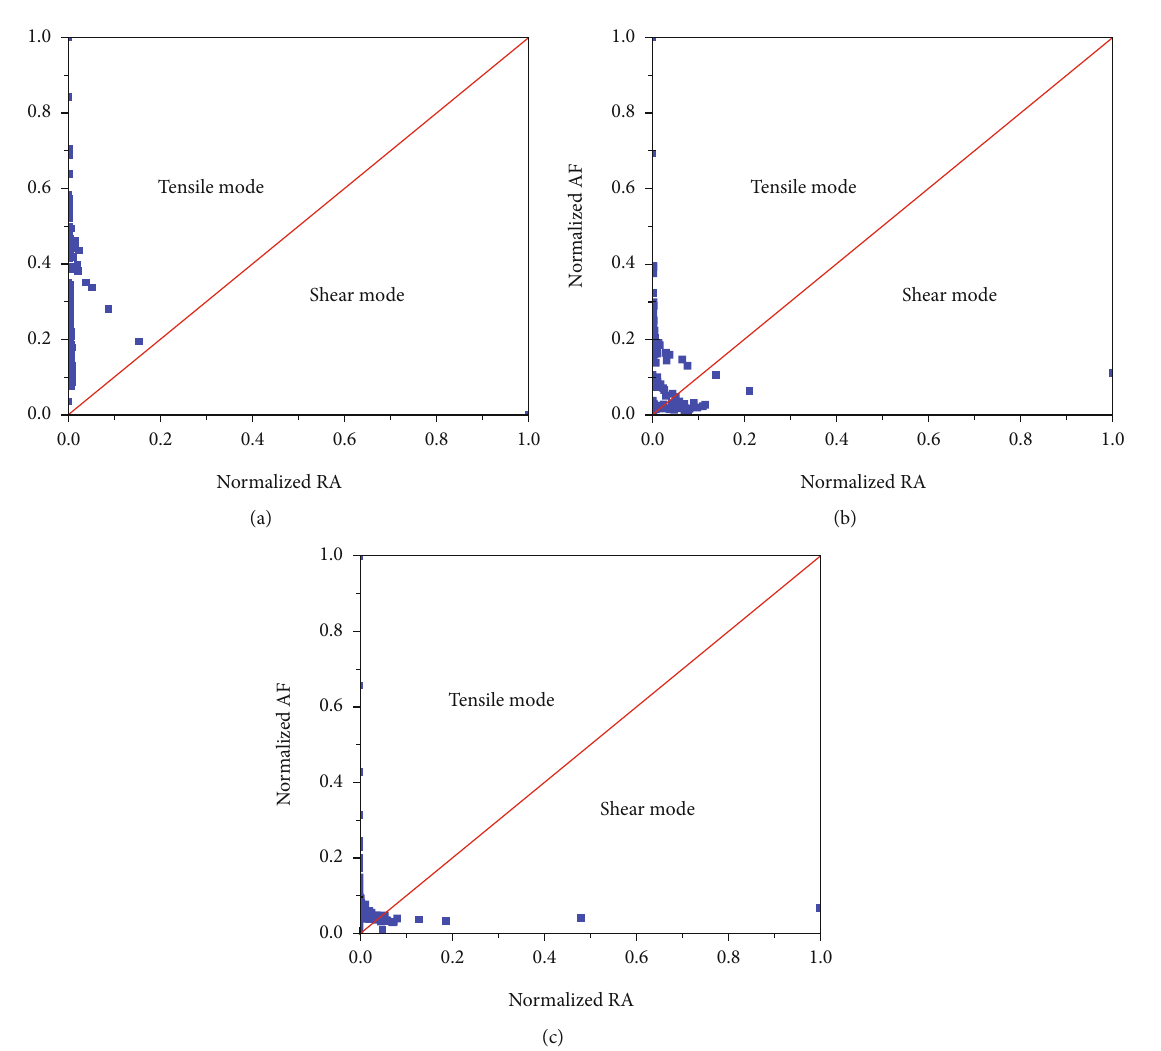
Figure 10: Distribution of RA-AF values in granite at di ff erent strain rates under uniaxial compression test: (a) 0.5mm/min, (b) 1 mm/min, and (c) 5